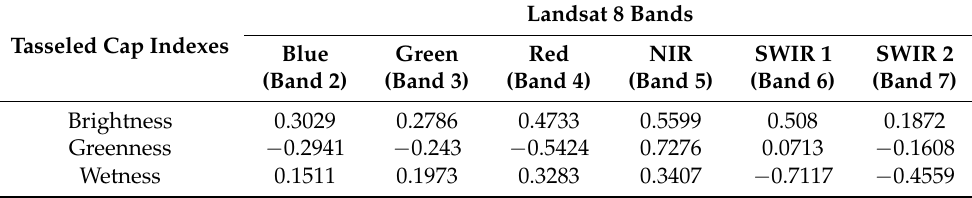
Table 2. Tasseled cap transformation coefficients for Landsat 8 at-satellite reflectance of six bands: Blue, Green, red, near-infrared (NIR), shortwave infrared (SWIR 1), and shortwave infrared (SWIR 2) (adopted from Baig et al.